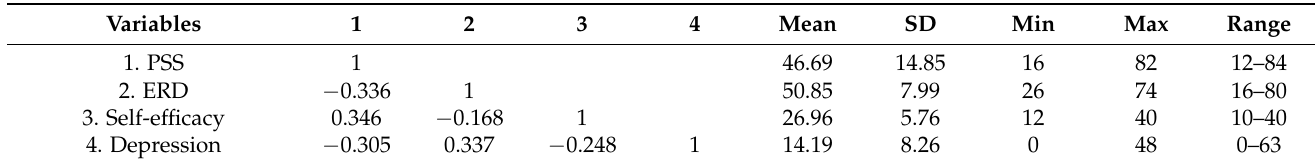
Table 2. Means, standard deviations, minimum values, maximum values, and correlation coefficients between variables of interest.